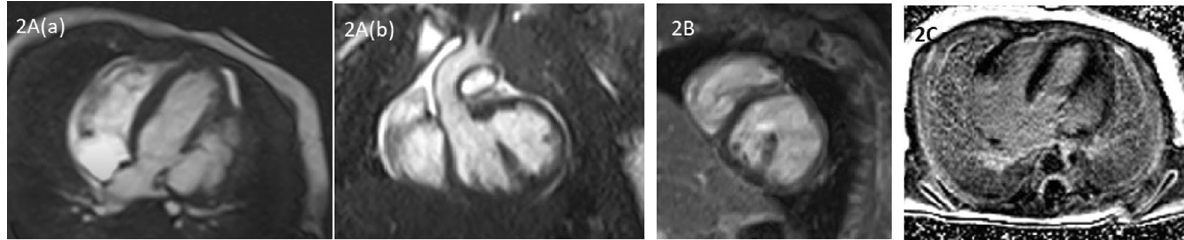
Fig. 2 A : Apical 4 chamber (a) and LVOT (b) view showing double chambered left ventricle. B : Early gadolinium image showing double chambered LV with no evidence of thrombus. C : Late gadolinium image with no evidence of myocardial